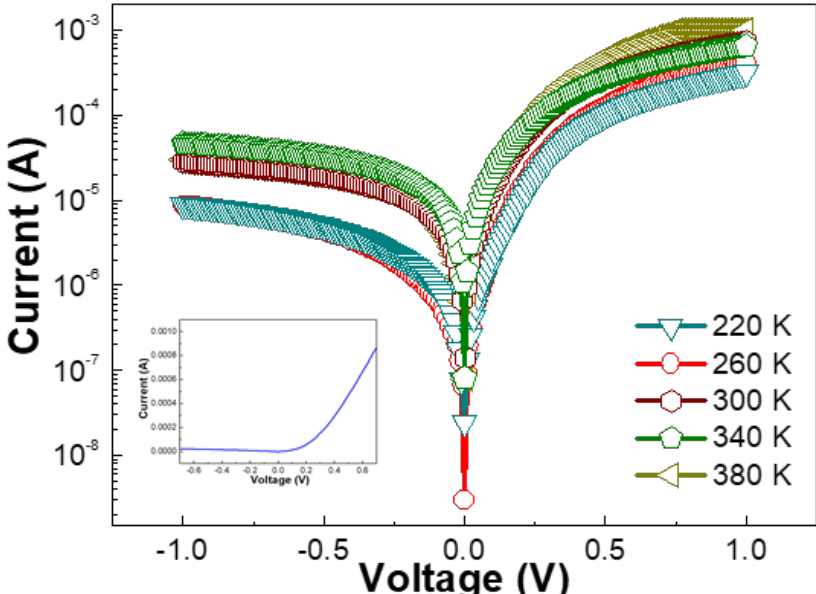
Figure 2. The T-I–V characteristics of the Pd Schottky diodes based on the freestanding GaN crystals peeled off from a Si substrate.